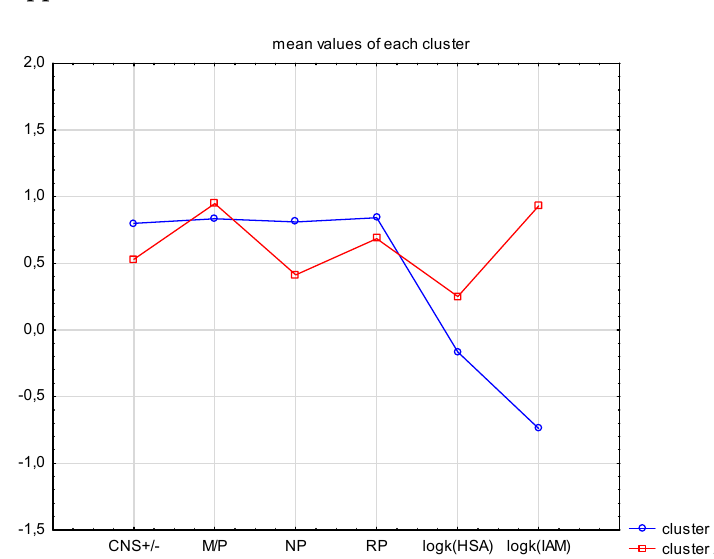
Figure A1 . Mean values graph of the chromatographic data for two clusters . Figure A1. Mean values graph of the chromatographic data for two